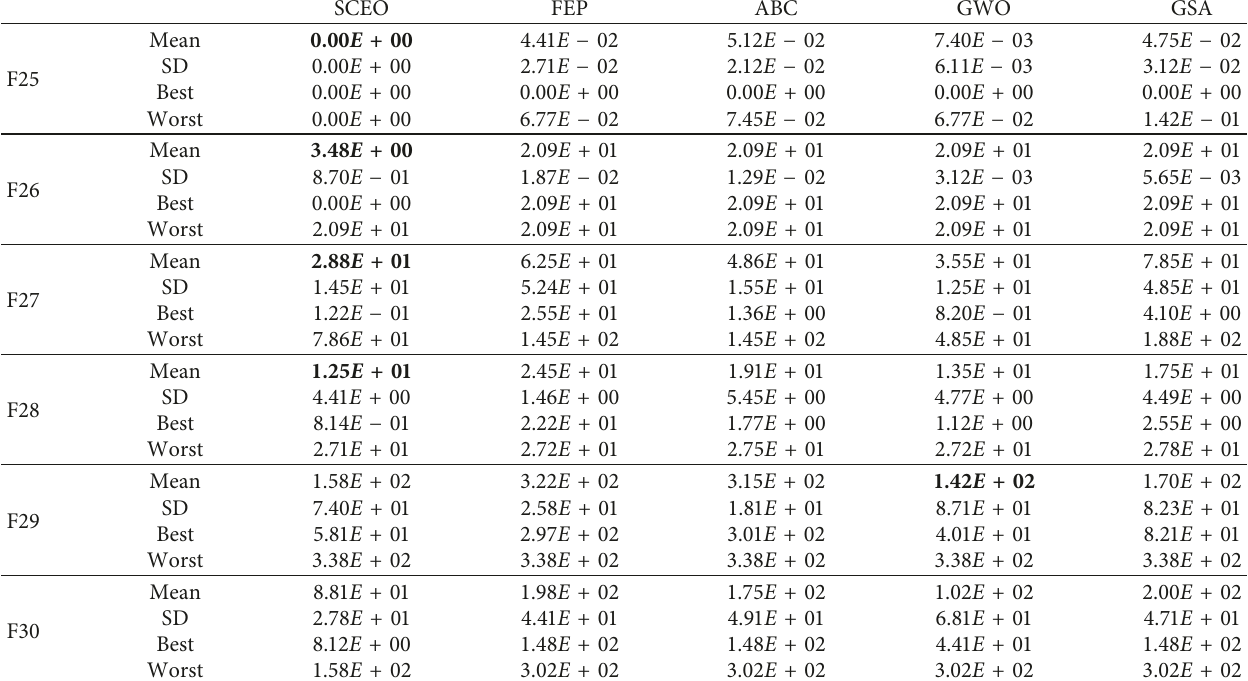
Table 9: Comparison with FEP [15], ABC [29], GWO [7], and GSA [30].